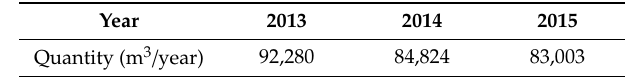
Source: Own elaboration.